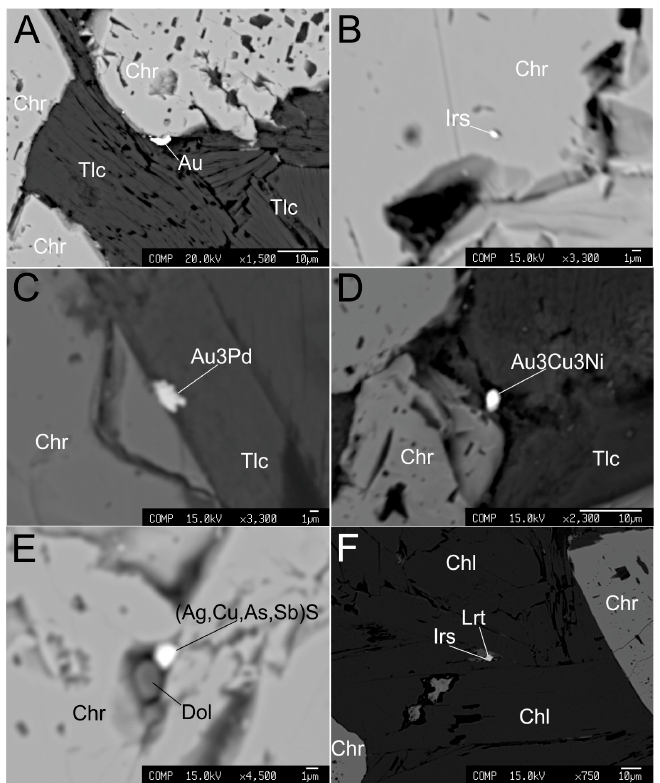
Figure 11. BSE images of PGM, Au and Ag minerals. ( A ) Native gold at the chromite/matrix interface; ( B ) Irarsite included in chromite; ( C ) Unnamed gold and palladium alloy (Au 3 Pd) in the chromite/matrix interface; ( D ) Unnamed gold, copper and nickel alloy (Au 3 Cu 3 Ni) in the chromite/matrix interface; ( E ) Unidentified silver, copper, arsenic and antimony sulfide (possibly pearceite: [(Ag 8 CuS 4 )][(AgCu) 6 (As,Sb) 2 S 7 ]) included in chromite; ( F ) Laurite and irarsite association in the matrix. Abbreviations: (Ag,Cu,As,Sb)S = unidentified sulfide, Au = gold, Au 3 Pd = unnamed PGE alloy, Au 3 Cu 3 Ni = unnamed gold alloy, Chr = chromite, Chl = chlorite, Dol = dolomite, Irs = irarsite, Lrt = laurite, Tlc= talc. Table 5. Electron microprobe analyses of Au and Pd minerals from the Cedrolina chromitite. Au 3 Pd